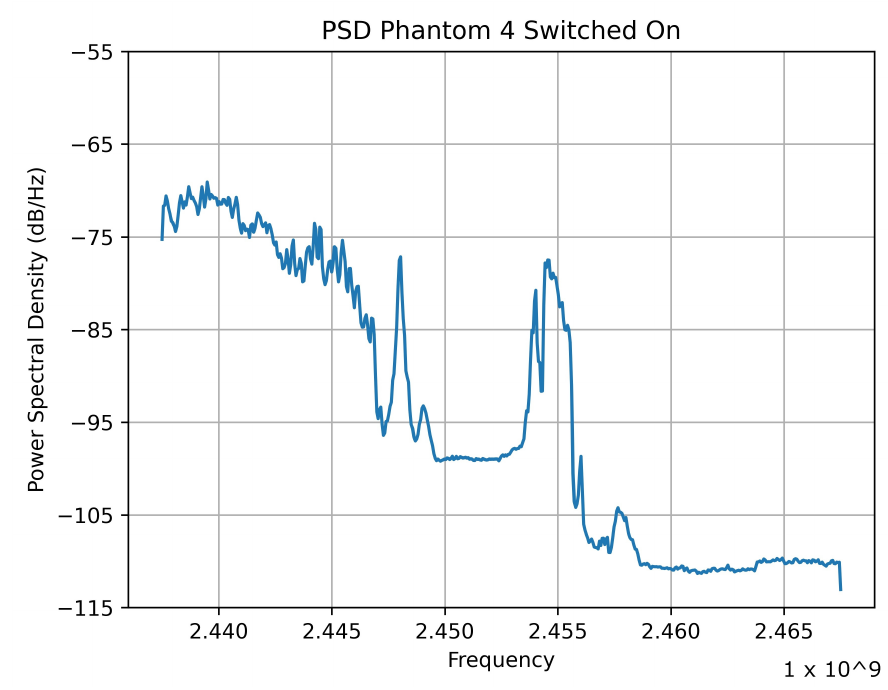
Figure 5. PSD: Phantom 4 switched on.